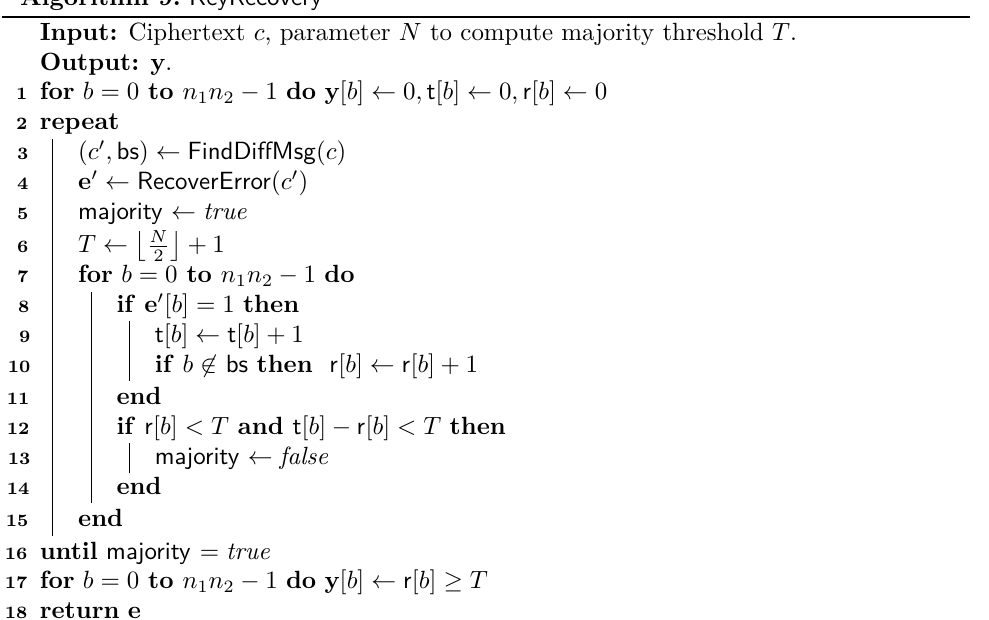
236 Key-Recovery Timing Attacks Due to Rejection-Sampling in HQC and BIKE